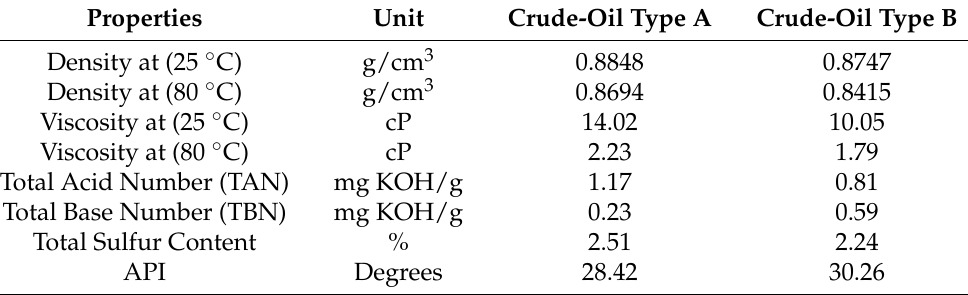
Table 2. Crude oils (Type A and Type B) characterization